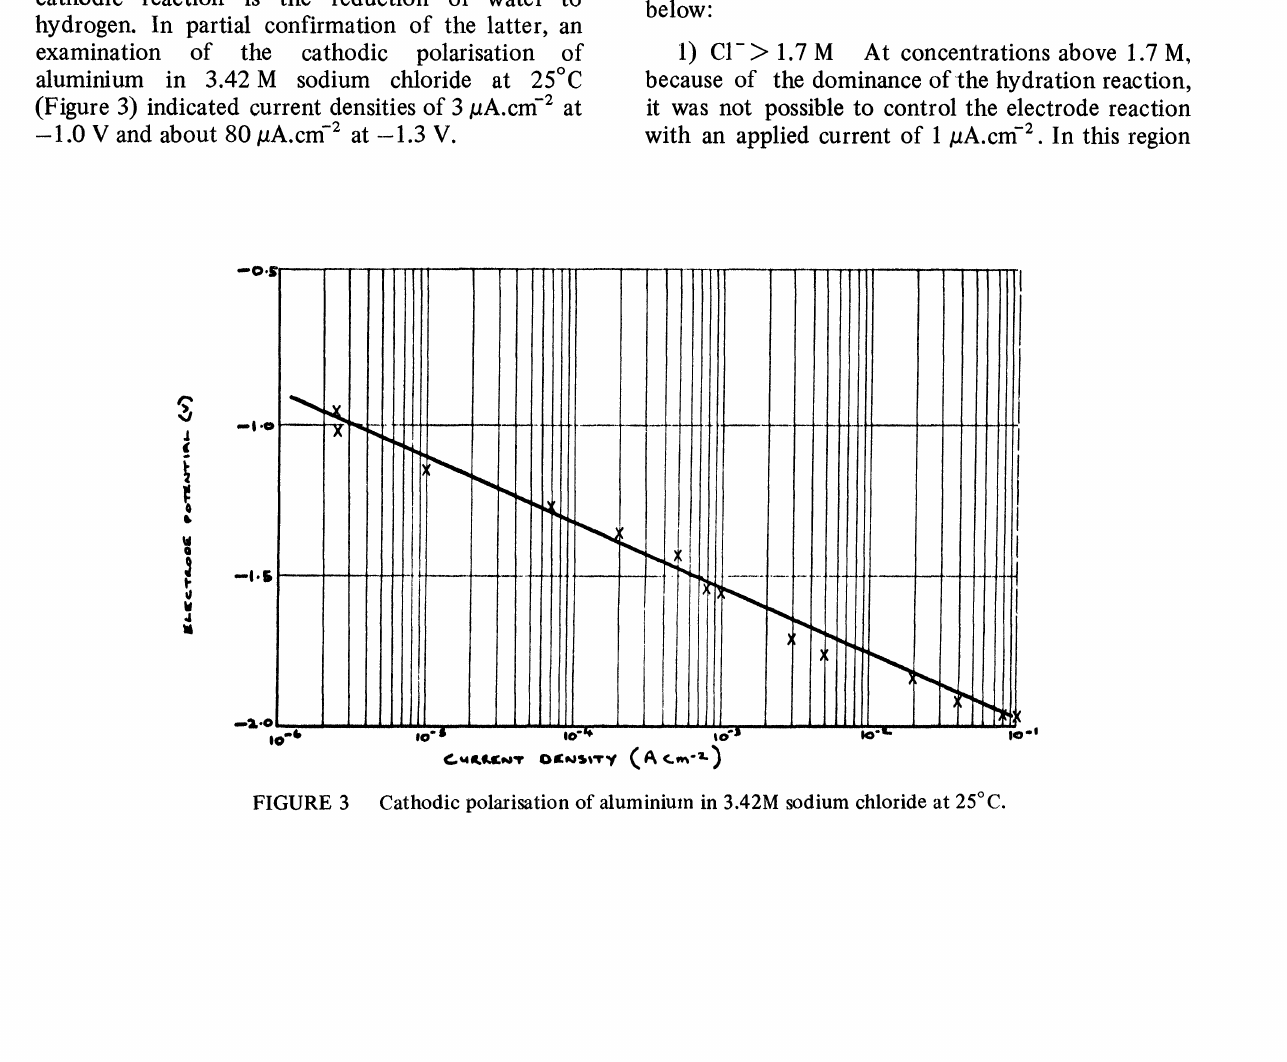
FIGURE 3 Cathodic polarisation of aluminimn in 3.42M sodium chloride at 25